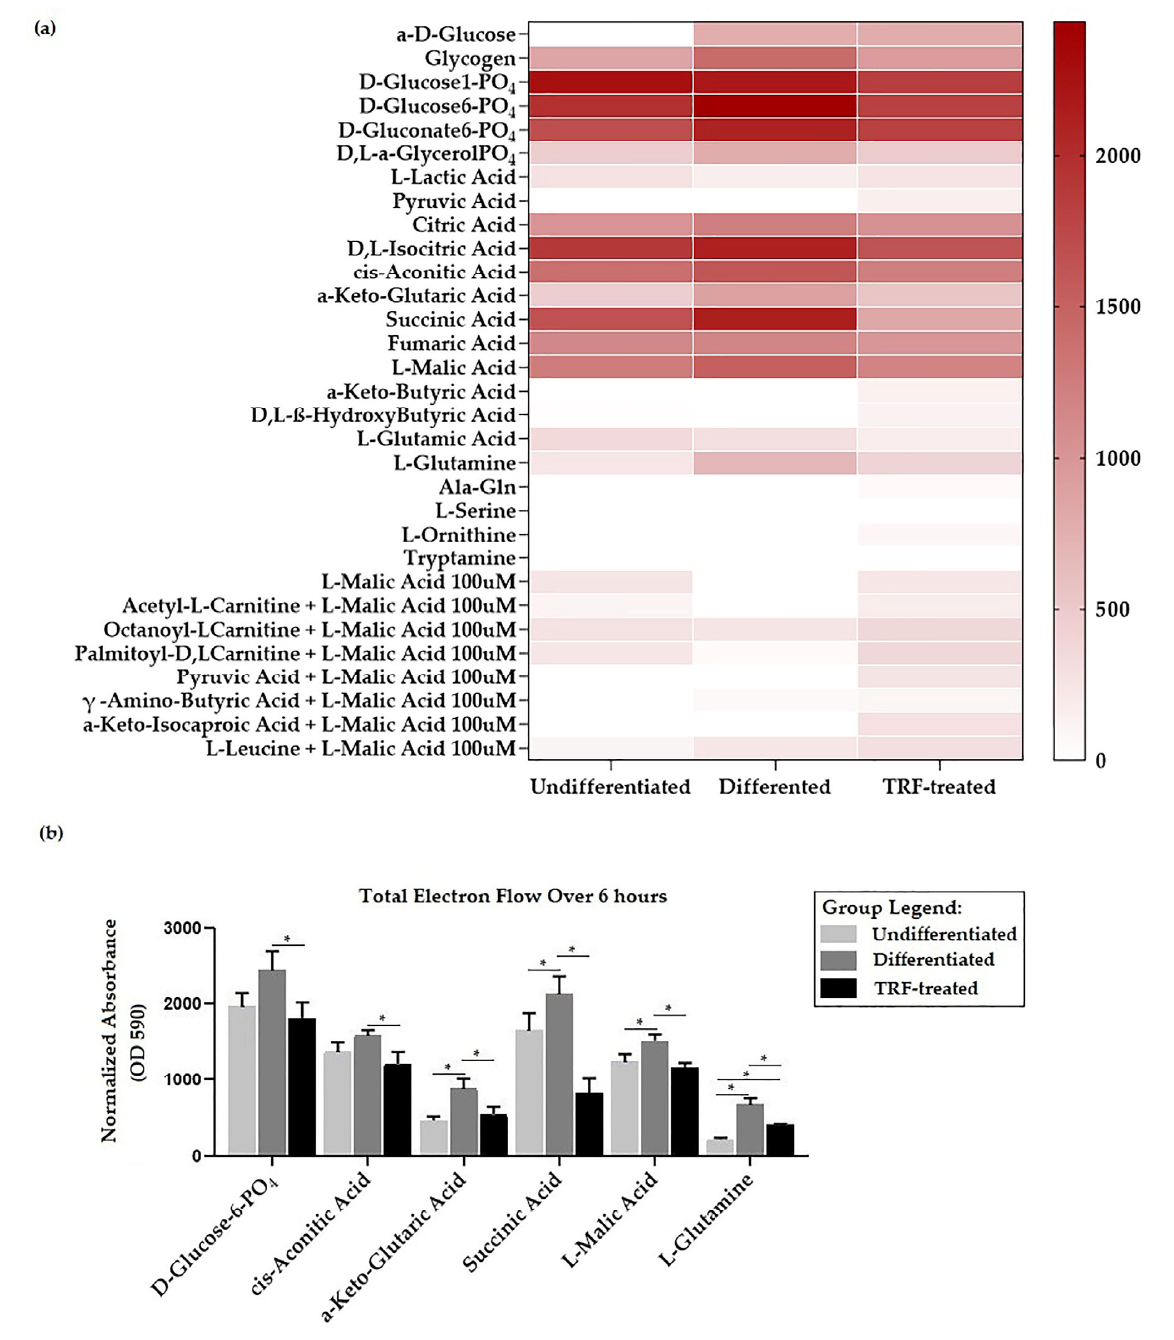
Figure 5. Mitochondria substrate oxidation profile. ( a ) Heatmap showing the rate of electron flow for 31 substrates. ( b ) Graph of total electron flow of substrates, indicating significant differences between groups. * indicates p < 0.05. Note: Total electron flow over time was determined by calculation of the area under the curve for absorbance reading taken over 6 h of kinetic measurements.